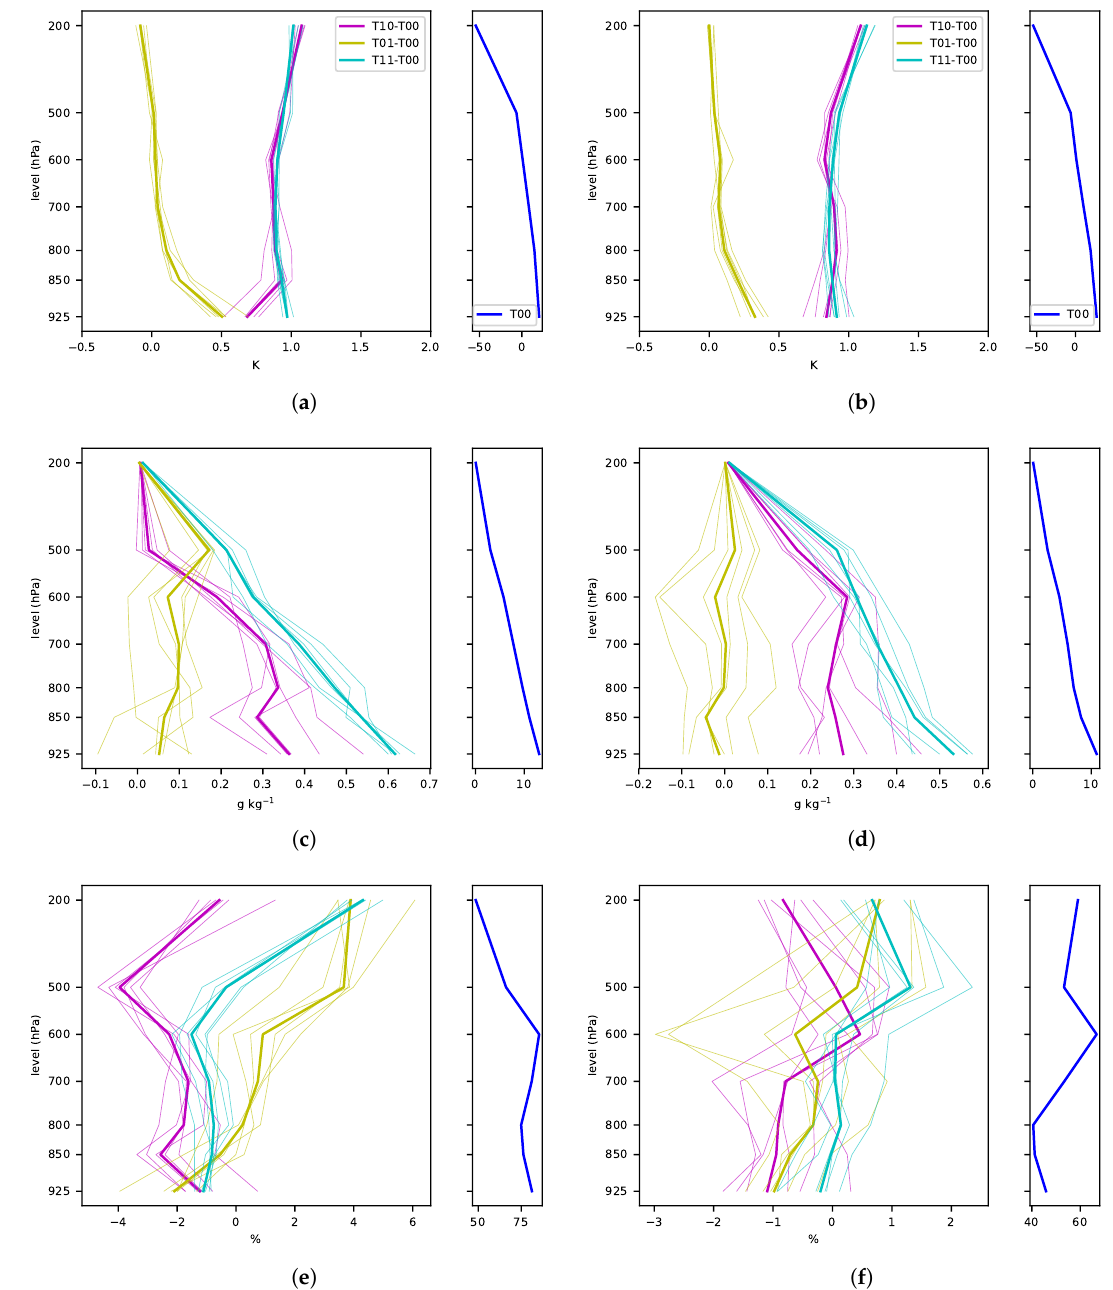
Figure 7. Mean JAS vertical profiles of air temperature ( a , b ), specific ( c , d ) and relative ( e , f ) humidity anomalies for Guinea ( a , c , e ) and Sahel ( b , d , e ). The reference vertical profile of each variable is shown on the right of each plot. Thick lines are study period medians and thin lines are individual